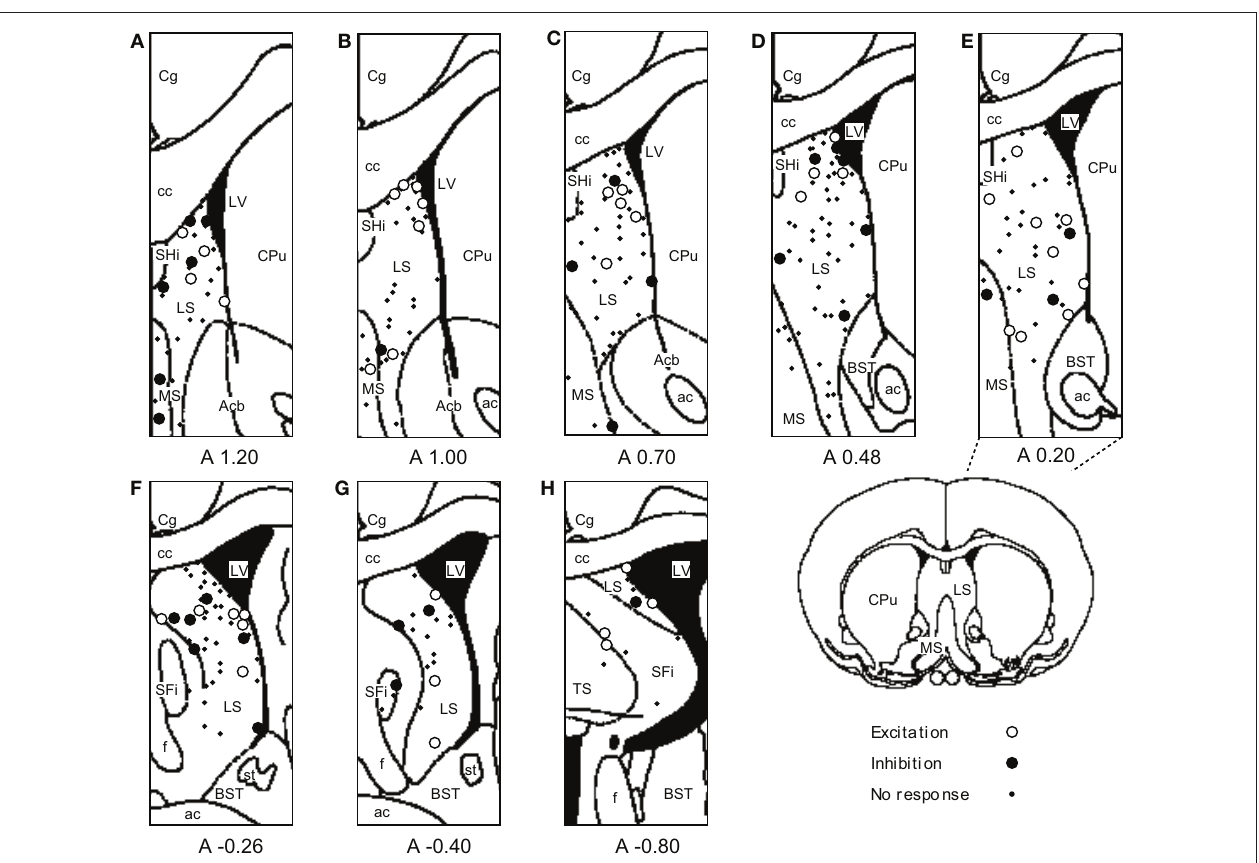
commissure; Acb, accumbens nucleus; BST, bed nucleus of the stria terminalis; cc, corpus callosum; Cg, cingulate cortex; CPu, caudate putamen; f, fornix; LS, lateral septal nucleus; LV, lateral ventricle; MS, medial septal nucleus; SFi, septofimbrial nucleus; SHi, septohippocampal nucleus; st, stria terminalis;